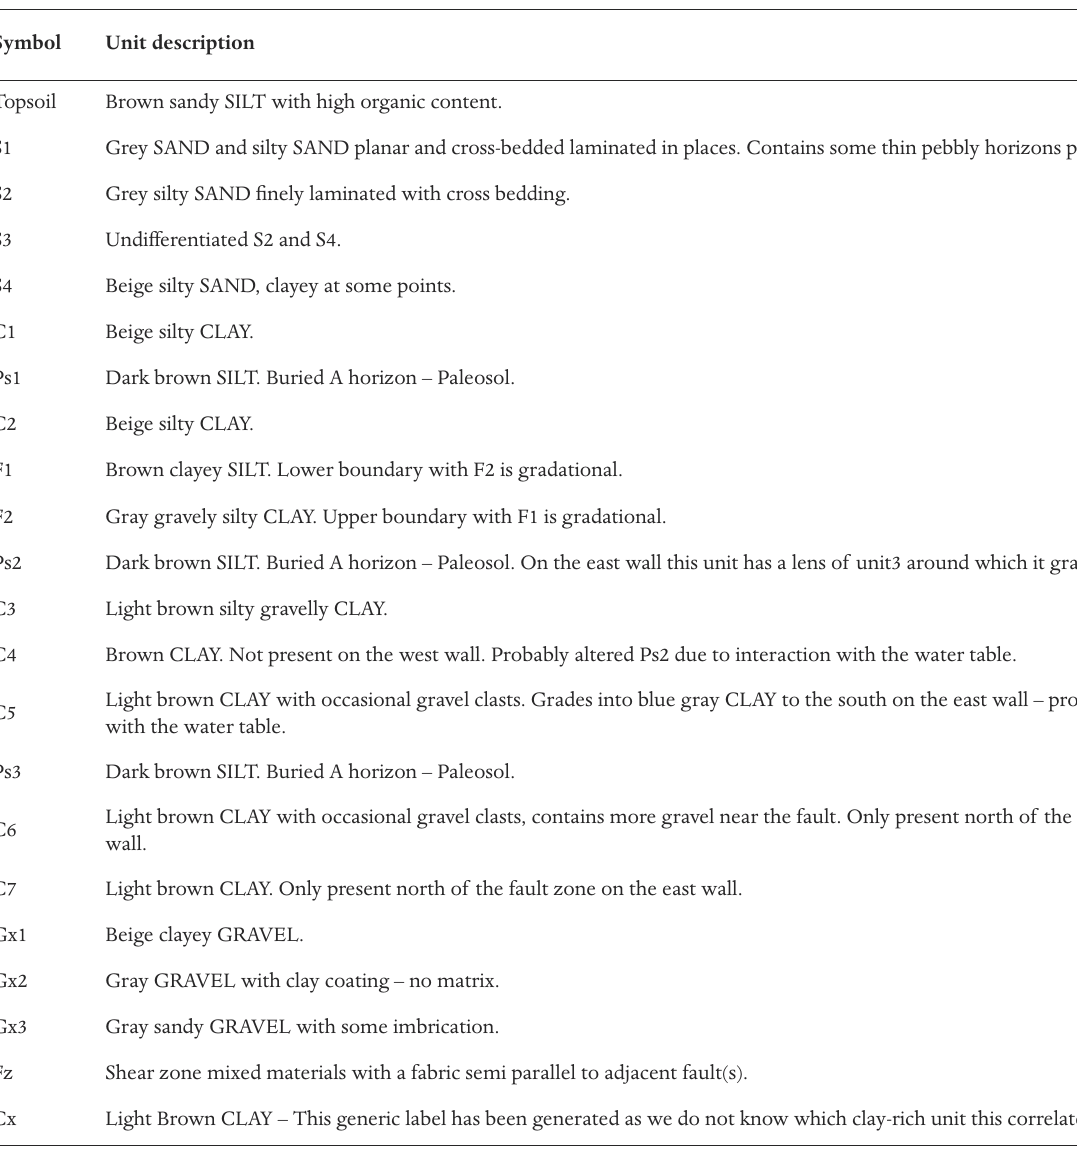
Table A.A-1. Paleoseismic trench T1: trench log stratigraphic unit descriptions. Symbols used on Figures 3 and